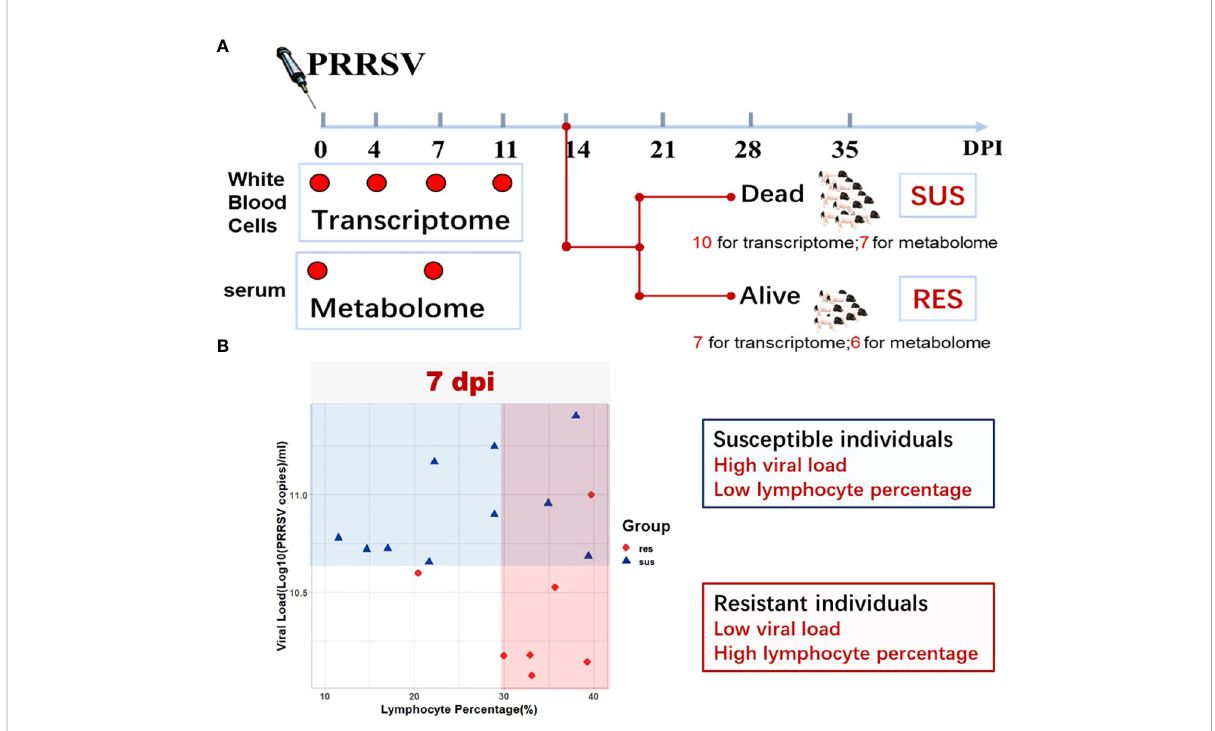
FIGURE 1 Study Overview. (A) Schematic representation of the experimental design in terms of sample types, target tissues, and sampling time points (0 dpi, 4 dpi, 7 dpi, 11 dpi) after PRRSV infection. (B) Serum viral loads and peripheral blood lymphocyte percentages in susceptible and resistant